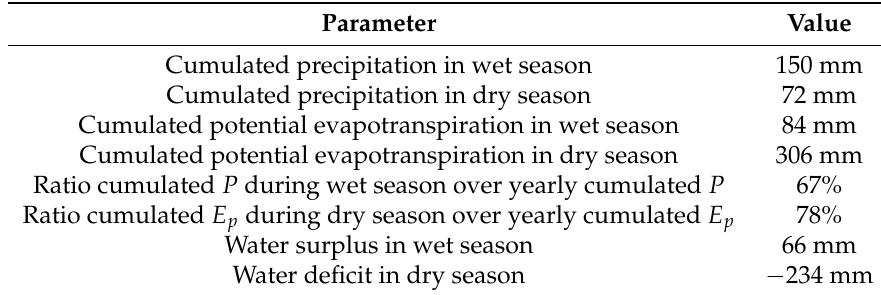
Table 6. Summary of agricultural water deficit and surplus in the basin for m =